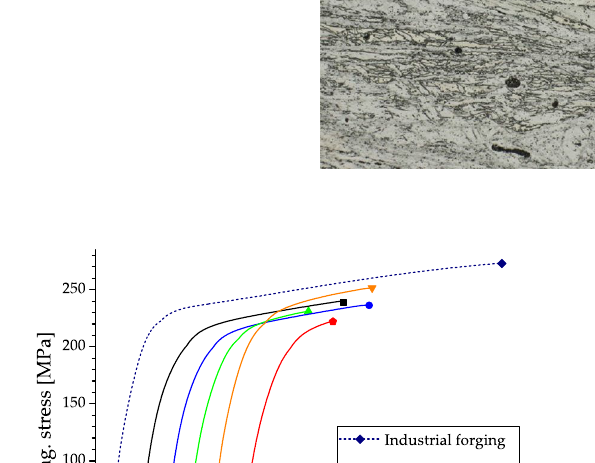
Fig. 7 Microstructure (OM images) of industrially forged automotive control arm in a as- forged state and b T6 temper